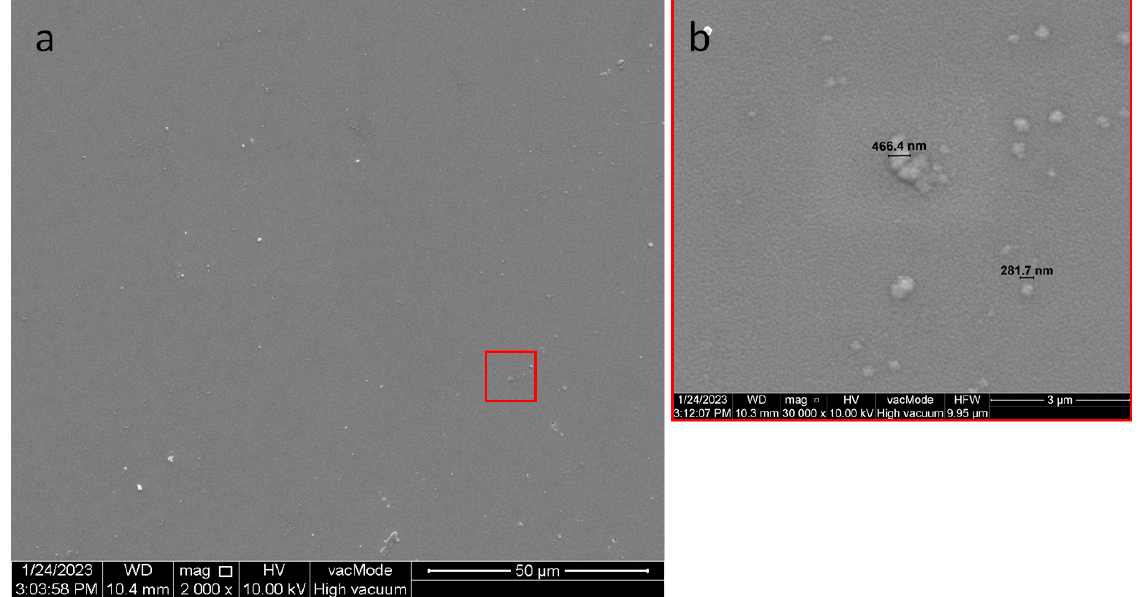
Figure 7. SEM images of the structure before annealing in 50 µm ( a ) and 3 µm ( b ) resolution.